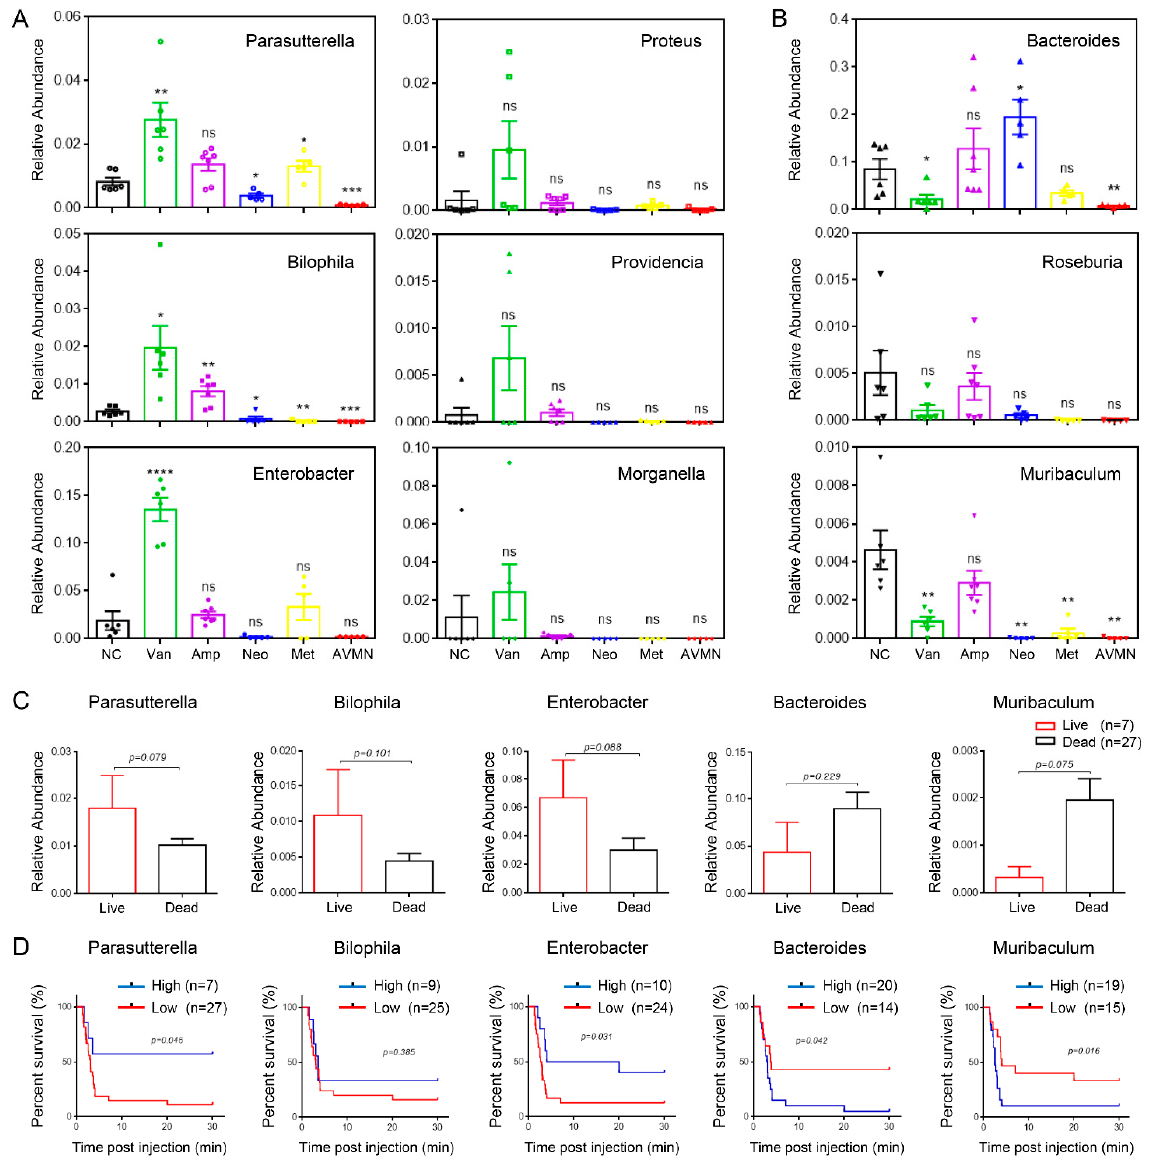
Figure 4. Vancomycin-induced gut microbiota changes protect against pulmonary embolism. ( A , B ) Bar chart showing the relative abundance of gut microbes enriched ( A ) and decreased ( B ) at genus level in vancomycin-treated mice, compared with NC group. Each dot represents a mouse. Van, Amp, Neo, Met, and AVMN group were compared with NC group. ( C ) Bar chart showing the relative abundance of gut microbes at genus level in live and dead mice with APE. ( E ) Kaplan–Meier estimates for survival probability of APE mice based on the abundance levels of microbes. * p < 0.05, ** p < 0.01, *** p < 0.001, **** p <